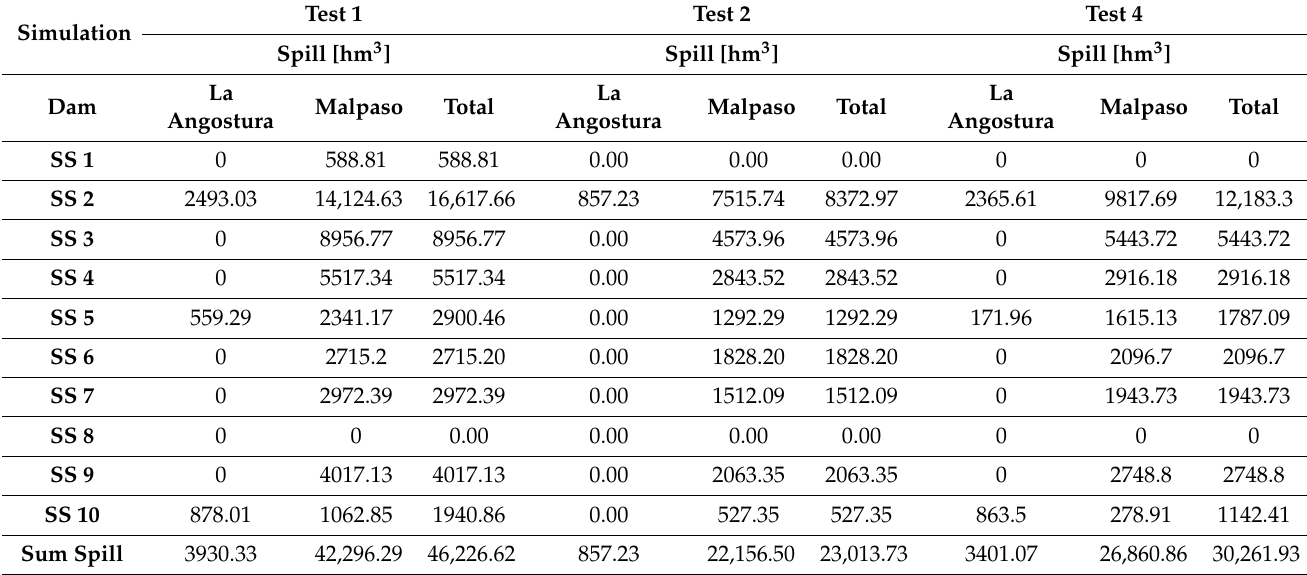
Table 12. Comparison of spills during the long-term simulation of the 10 synthetic series.